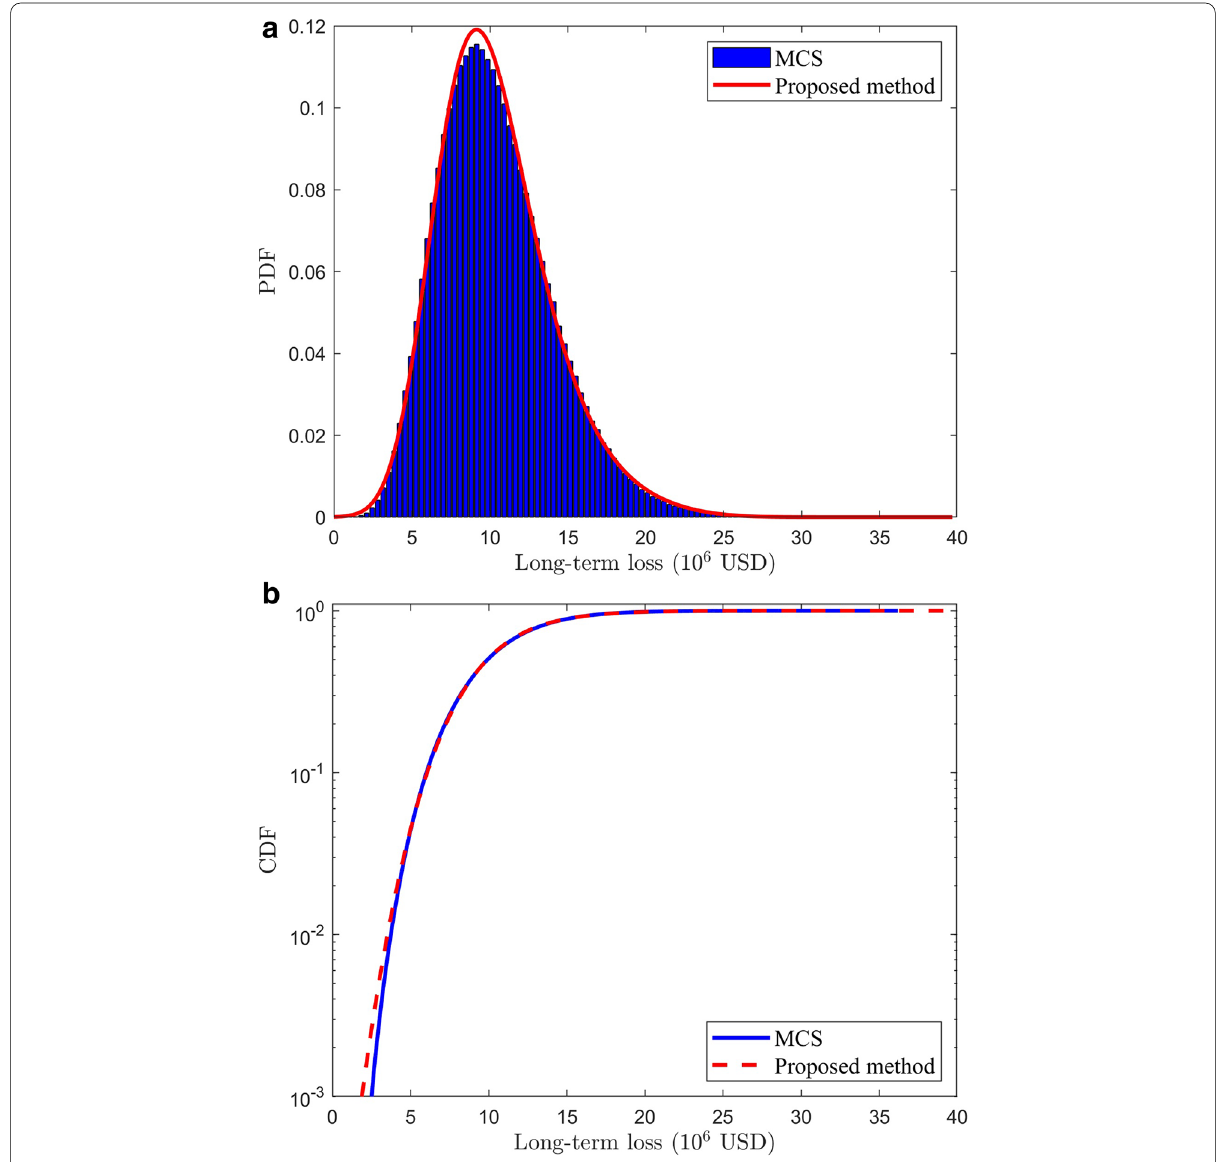
Fig. 6 ( a ) PDF and ( b ) CDF of long-term loss obtained by Monte Carlo simulation and proposed method (150 years, r